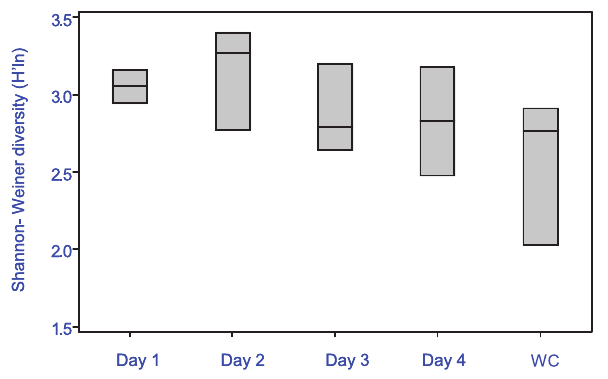
Figure 6. Box-plot showing Shannon-Weiner diversity index of the SML samples of Acropora muricata taken over four consecutive days, based on DGGE 16S rRNA gene diversity compared to that of the water column (WC).